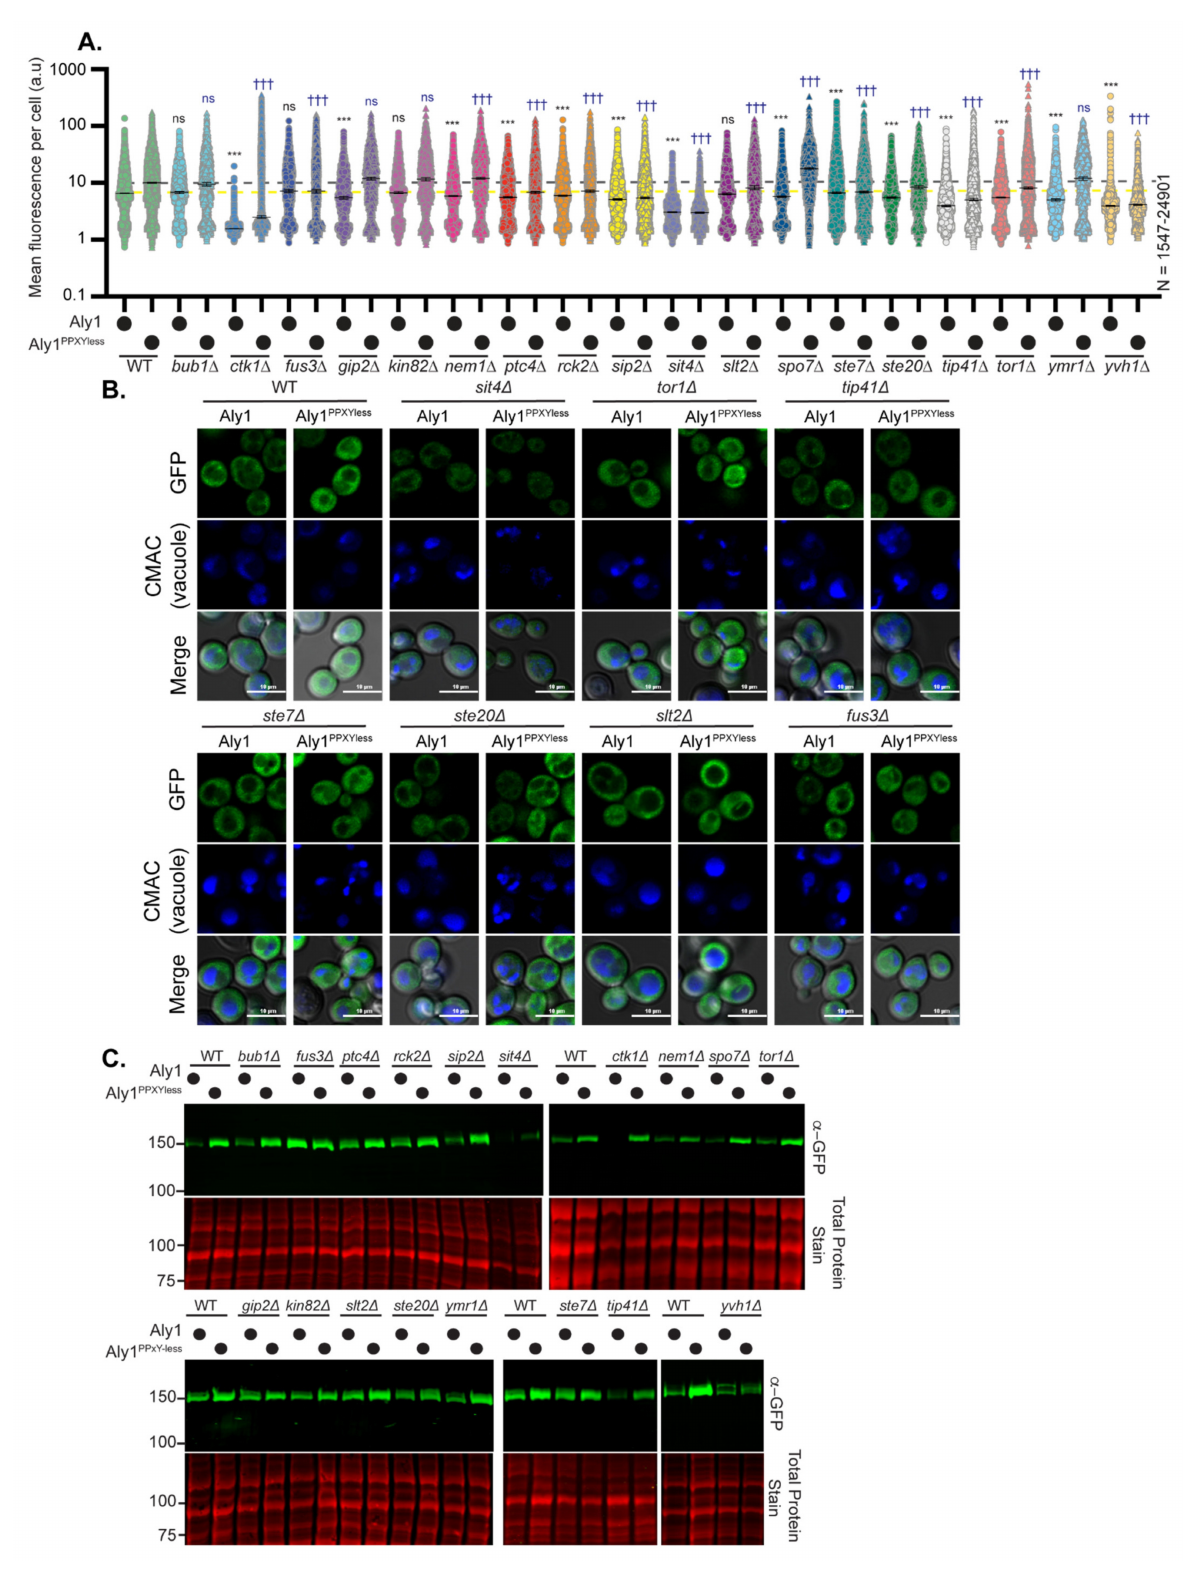
Figure 3. Kinases and phosphatases from the KinDel screen alter the abundance and electrophoretic mobility of Aly1: ( A ) Cells expressing the indicated Aly1 protein fused to GFP (pRS415- TEF1pr plasmids) in either WT or the noted gene deletion backgrounds were imaged by high-content